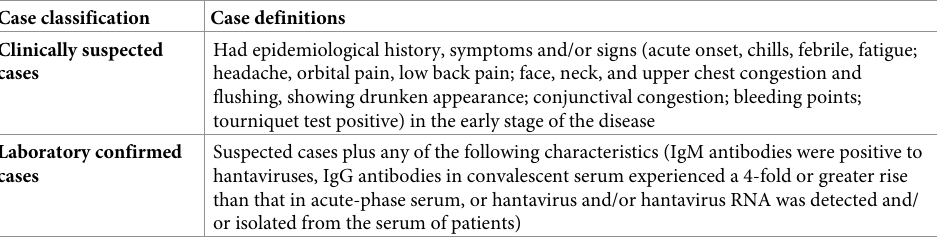
Table 1. Case definitions of